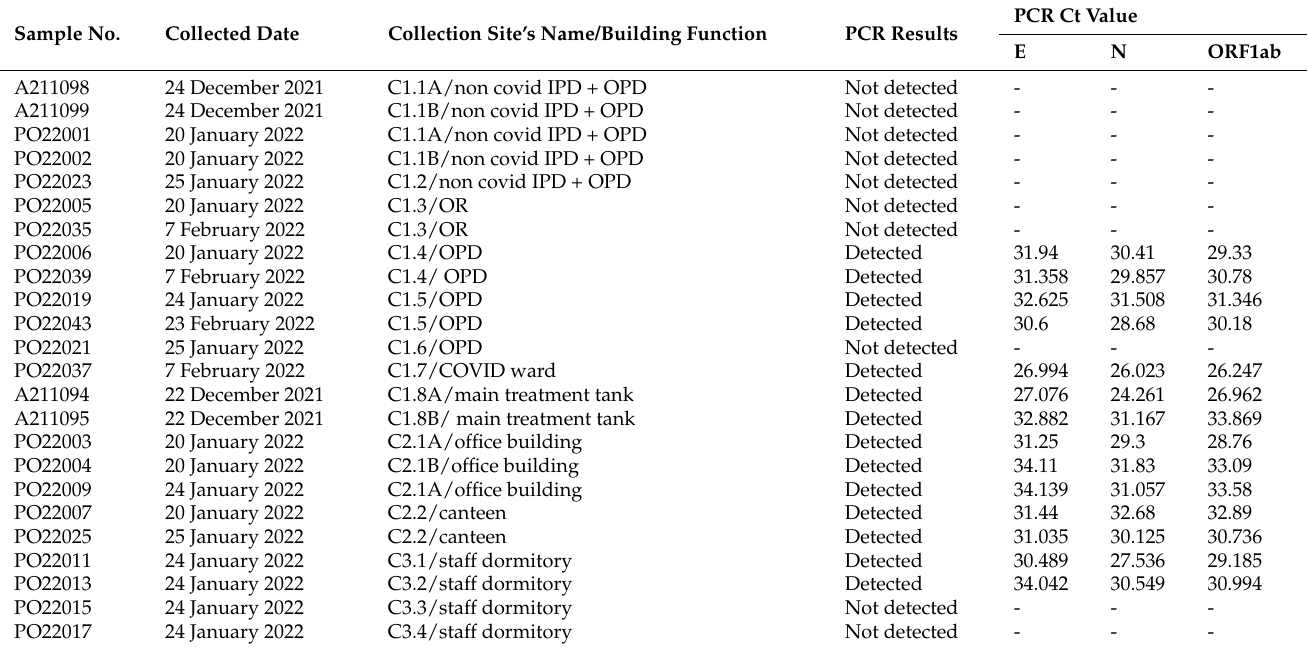
Table 4. SARS-CoV-2 RT-PCR results in wastewater samples collected from various sites at the hospital in Bangkok from December 2021 to February 2022.